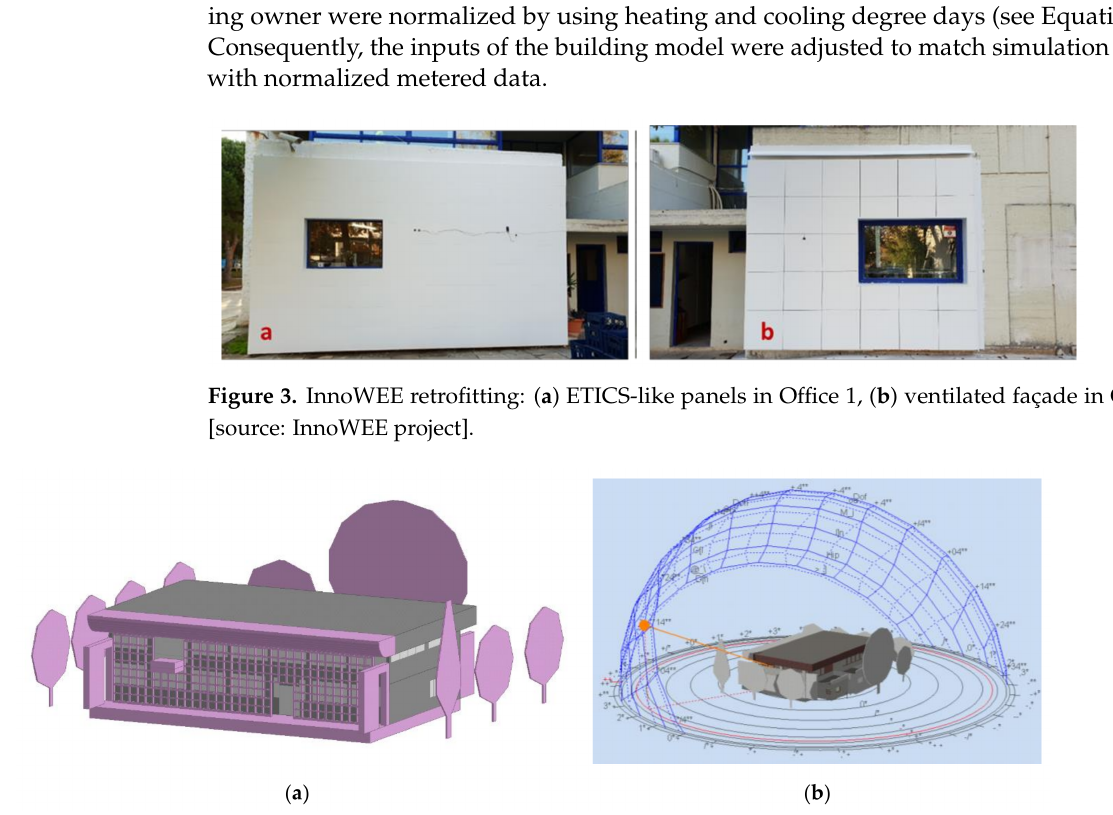
Figure 4. Virtual model. Voula Town Hall, Greece. ( a ) Building geometry and ( b ) Sunpath